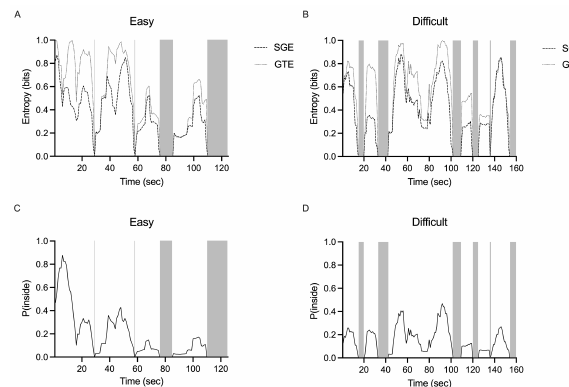
Figure 6. Representative time traces that reflect the stationary gaze entropy (SGE) and gaze transition entropy (GTE) of a single easy (A) and difficult (B) trial. Exemplar time traces showing the probability of fixating inside the cockpit for the easy (C) and dif- ficult (D) conditions. These reflect the same easy (A and C) and difficult (B and D) trials. Gray boxes represent the sections of the trial where entropy and P(inside) equals zero. This indicates that gaze is directed outside the cockpit for at least 10 seconds (i.e., a single bout). The easy condition illustrates four bouts with a total bout time of 68 sec (A). The difficult condition illustrates six bouts with a total bout time of 96 sec (B).